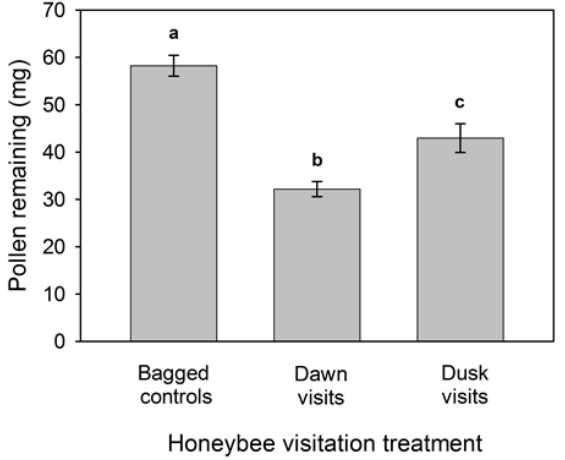
F IGURE 2. Mass of pollen remaining in unvisited control flowers, flowers open to pollinators at dawn only, and flowers open to pollinators at dusk only. Lines represent means and +/- 1 SE. Letters indicate percentages that are significantly different from each other at the P = 0.05